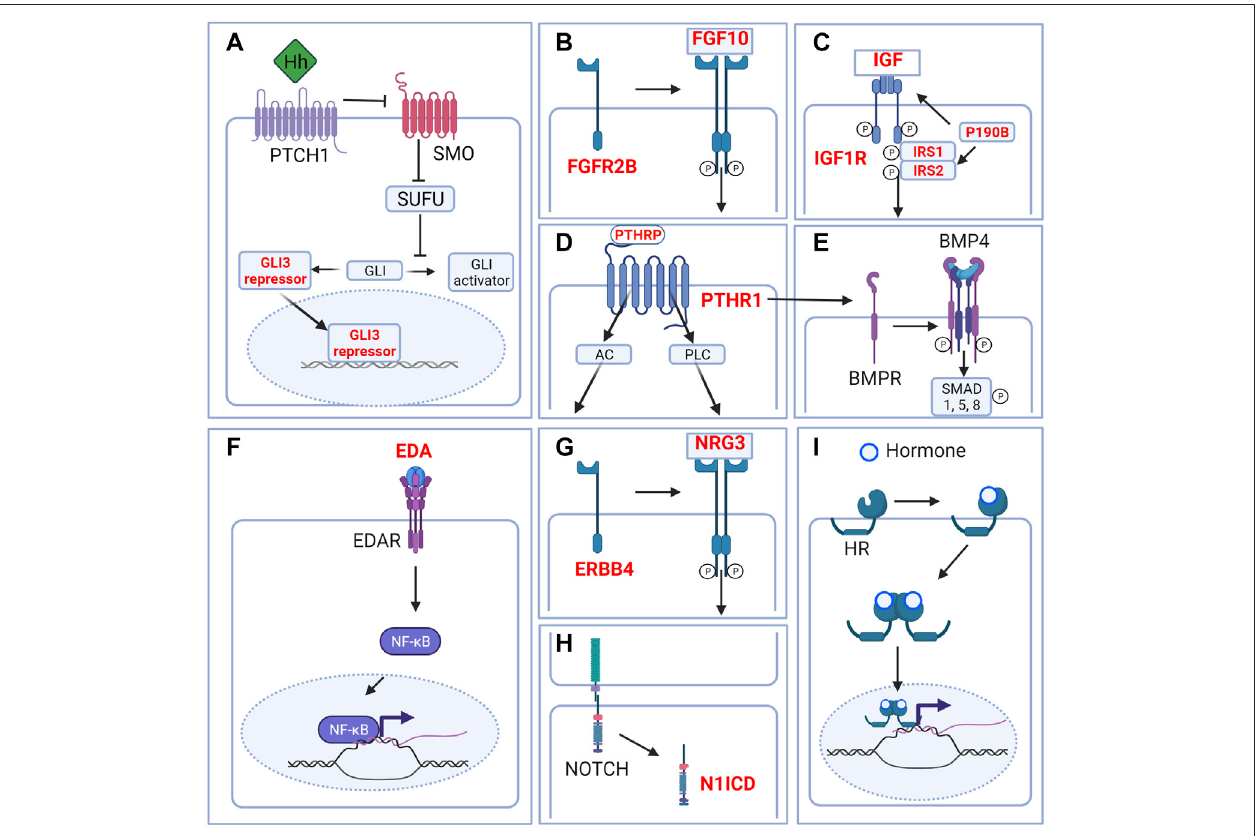
FIGURE 3 | Signaling pathways in the embryonic mammary gland. Cartoon depicting major signaling pathways that are critical during embryonic mammary gland development. (A) Hedgehog signaling. Although Hh ligands are expressed in the MRs, Hedgehog signaling is in the inactivated state. GLI is maintained in the repressor form torepress thetranscription ofHhtarget genes. (B) FGFsignaling.FGF10 bindingtoits mainreceptor, FGFR2Btriggersreceptor dimerization, phosphorylationand the activation of diverse downstream pathways. (C) IGF1R signaling. Ligand binding activates the receptor kinase, leading to receptor autophosphorylation, and tyrosinephosphorylationofmultiplesignalingadapterproteinsincluding,theinsulinreceptorsubstrates(IRS1/2). (D) PTHRPsignaling.PTHRPbindingtotheG-coupled receptor PTHR1 activates AC and PLC downstream signaling. (E) BMP signaling. Binding of ligand to the receptor complex stimulates BMPR autophosphorylation and phosphorylation of downstream substrates. BMP4 may interact with PTHRP signaling to facilitate epithelial-mesenchymal cross talk. (F) EDA-EDAR signaling. EDA binding to EDAR triggers downstream NF-kB signaling. (G) NRG3-ERBB4 signaling. NRG binding triggers receptor dimerization and activation of receptor tyrosine kinase domain and downstream signaling. (H) NOTCH signaling. Ligand binding triggers the cleavage of N1ICD which activates downstream signaling. (I) Hormone signaling. Binding of hormones such as estrogen or progesterone to their cognate hormone receptor (HR) promotes internalization of the hormone-receptor complex. Homo- or heterodimer formation ensues followed by translocation into the nucleus and binding to DNA response elements and transcription or repression of target genes. Only relevant components of each signaling pathway in embryonic mammary gland development are depicted. Genes highlighted in red denote genes that give rise to aberrant embryonic mammary gland phenotypes when deleted or overexpressed. P denotes phosphorylation events. Figure created with BioRender.